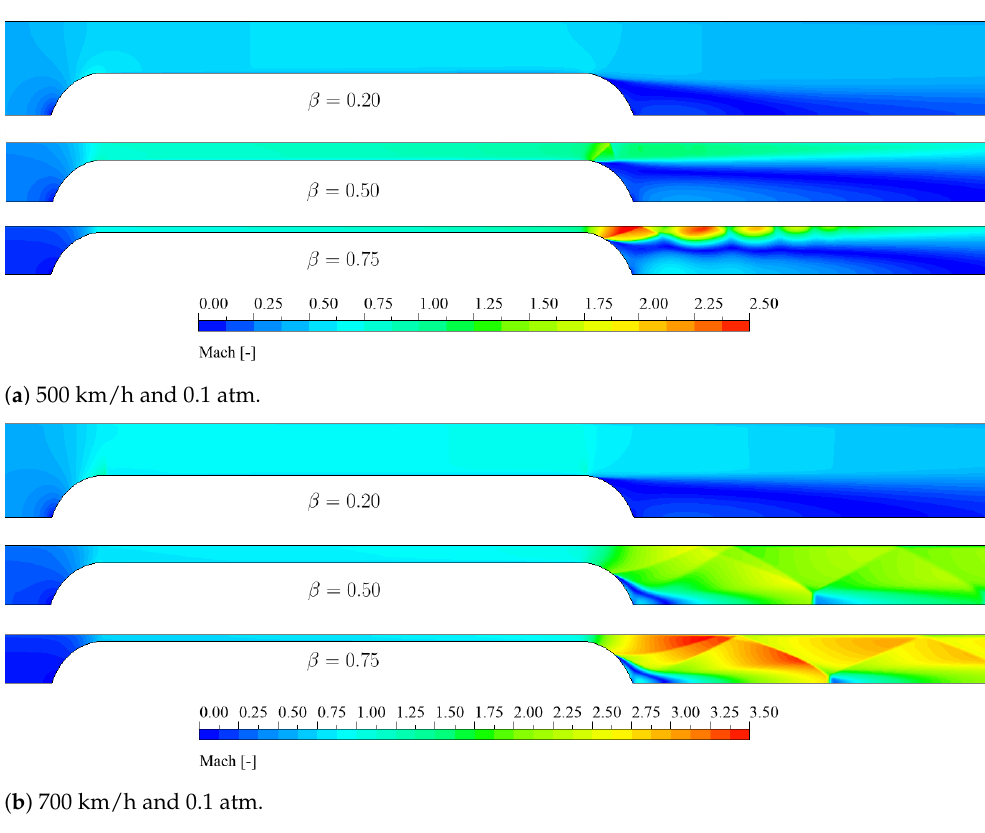
Figure 9. Mach contours for β = 0.2 ( upper ), β = 0.5 ( middle ), and β = 0.75 ( lower ) and differ- ent